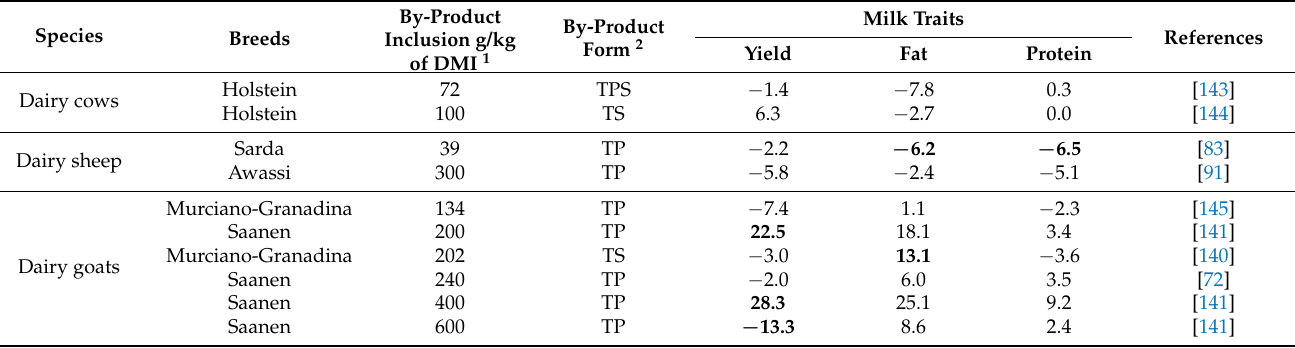
Table 8. Effect of tomato by-products included in dairy ruminants’ diets on milk yield, fat%, protein%, and the fat-to-protein ratio. Data are reported as the proportional difference between the treatment group, at the respective level of inclusion, and the control